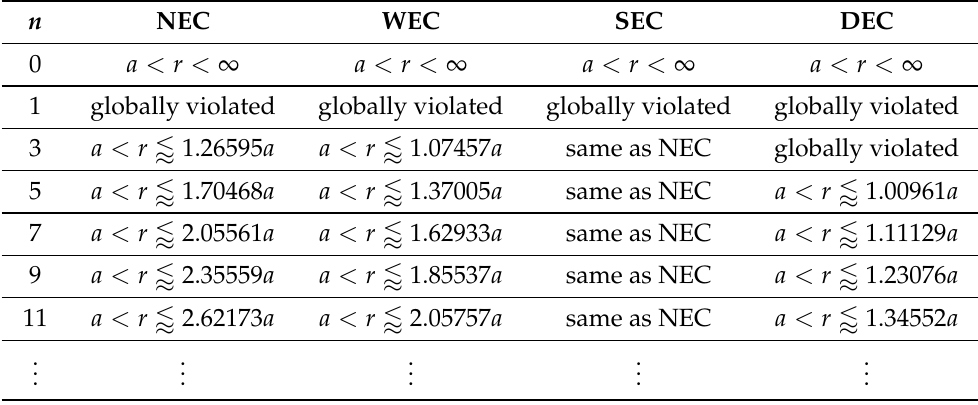
Table 2. Regions of the spacetime where the energy conditions are